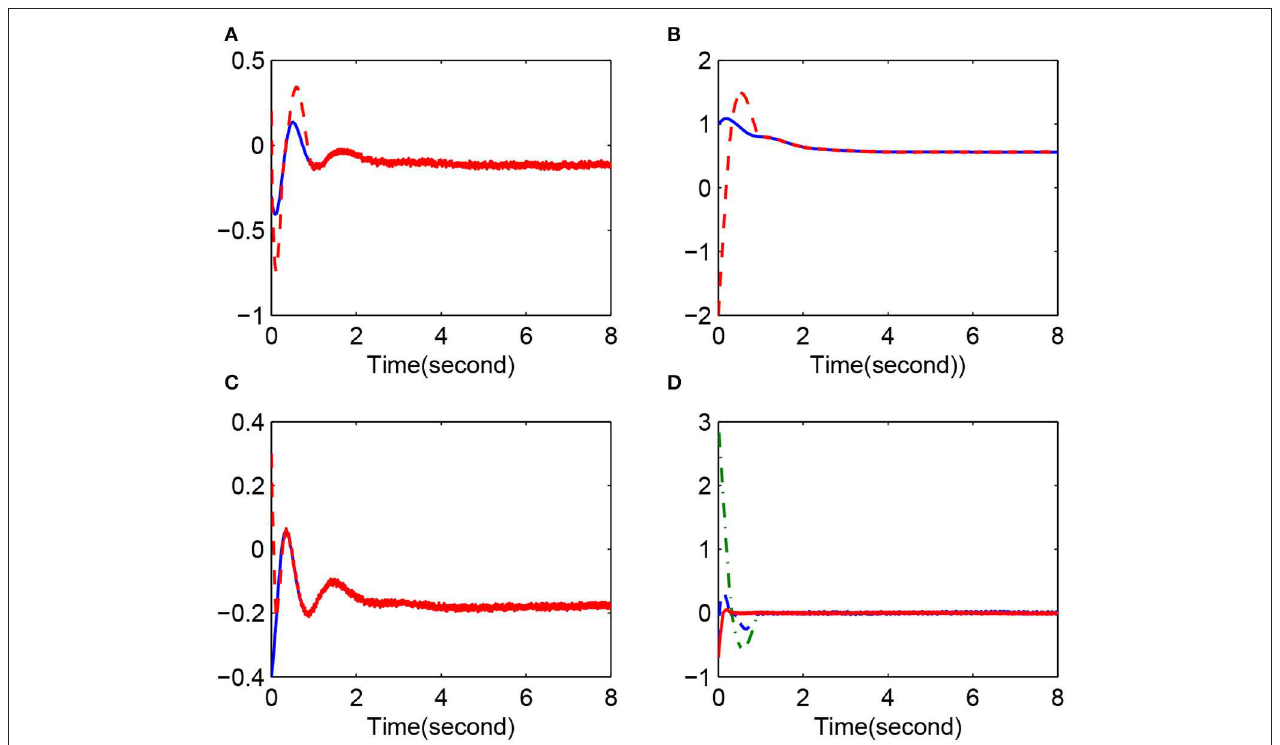
FIGURE 2 | Synchronization results of Case